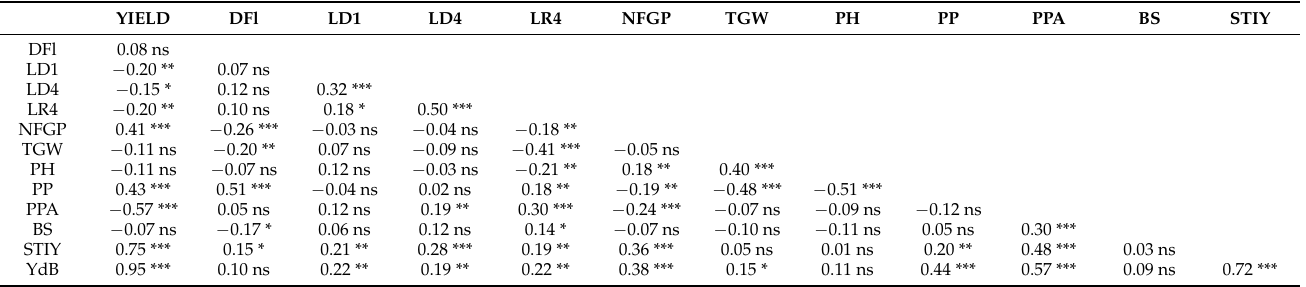
Table 5. Correlations between traits of evaluated rice genotypes for the field drought